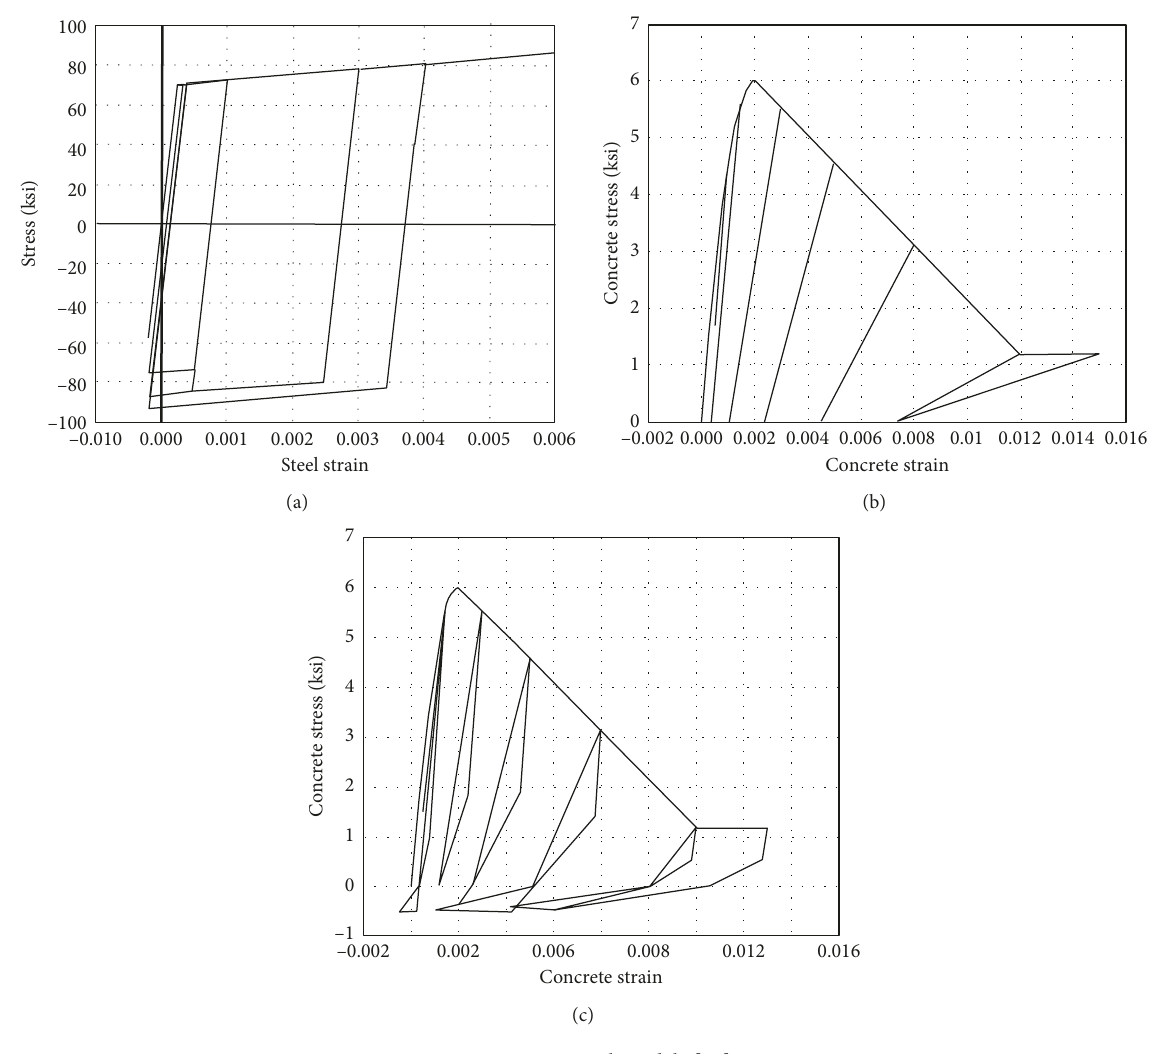
Figure 15: Material models [60]. Table 1: Parameters of concrete material [24]. Table 2: Parameters of steel material [24].